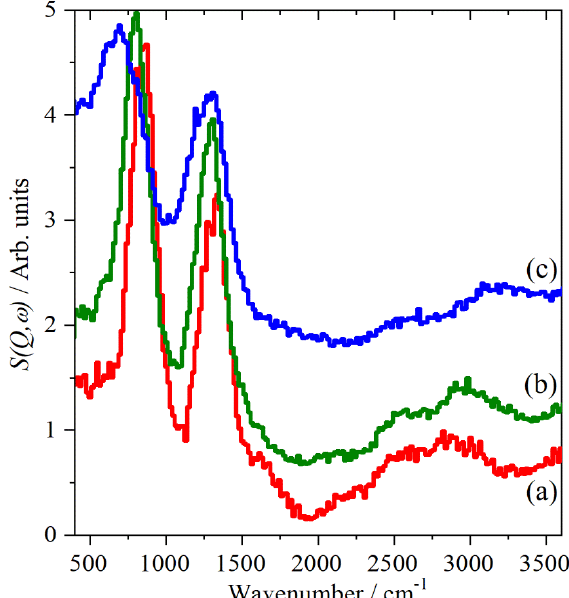
Figure 3. INS spectra recorded with MAPS of CsHSO 4 with 4840 cm − 1 incident energy. ( a ) Phase III at 300 K, ( b ) phase II at 300 K and ( c ) phase I at 430 K. The spectra are offset for clarity.